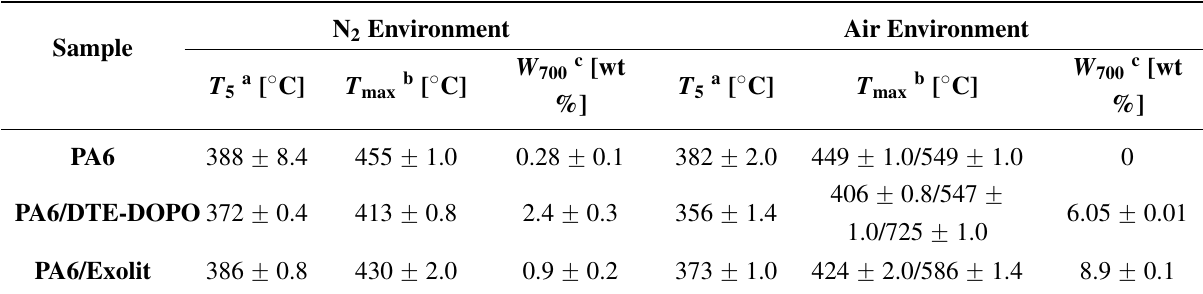
Table 1. Thermal properties of PA6 formulations in nitrogen and air